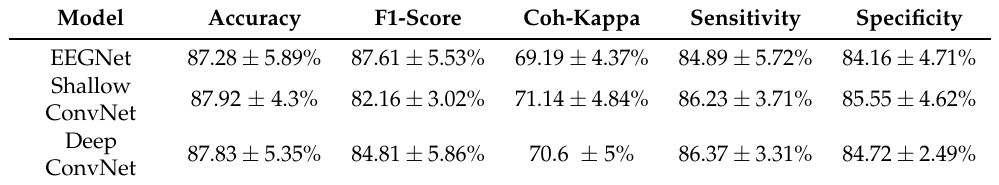
Table 3. LOSO classification performance for transition to FOG vs. transition to voluntary stopping.